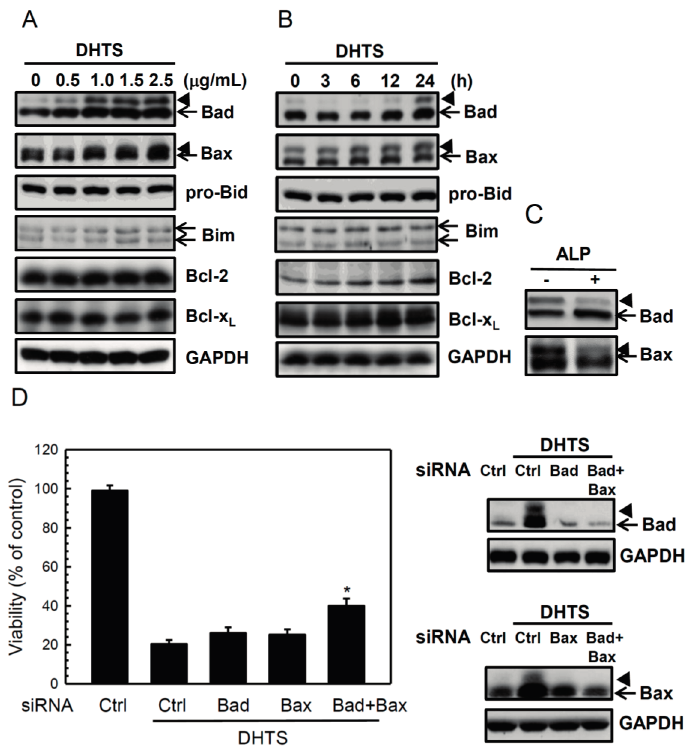
Figure 3. Effects of 15,16-dihydrotanshinone I (DHTS) on Bad and Bax expressions in human HL-60 promyelocytic leukemia cells. Cells were treated with ( A ) various concentrations of DHTS for 24 h or ( B ) 1.5 μ g/mL DHTS for different time periods, and total cellular proteins were collected to determine protein expressions by Western blotting; ( C ) Total cellular lysate were collected from the cells treated with 1.5 μ g/mL DHTS for 24 h, and incubated with or without alkaline phosphatase (ALP) in tube, and then determined protein expressions by Western blotting; and ( D ) Cells were transfected with Bad siRNA and/or Bax siRNAs by electroporation and then treated with 1.0 μ g/mL DHTS for 24 h. Cell numbers was measured by counting viable cells using an MTT assay ( left panel ), and total cell lysates were used to detect the Bad and Bax protein levels by Western blotting ( right panel ). Arrowhead, a shifted band of Bad or Bax. Data are expressed as the mean ± S.D. of three independent experiments. * p < 0.05, compared to the column